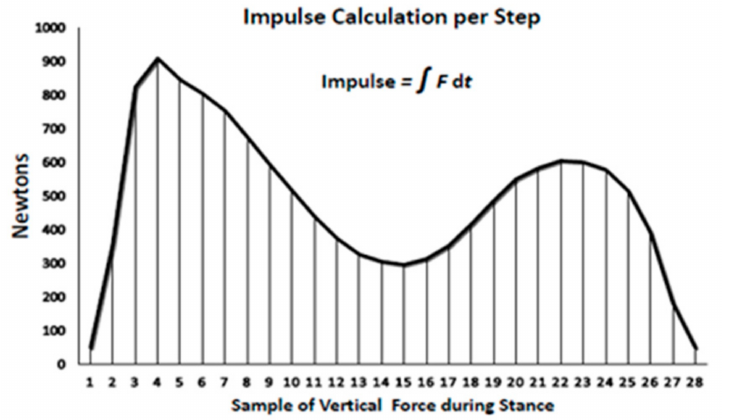
Figure 2. Impulse calculation per